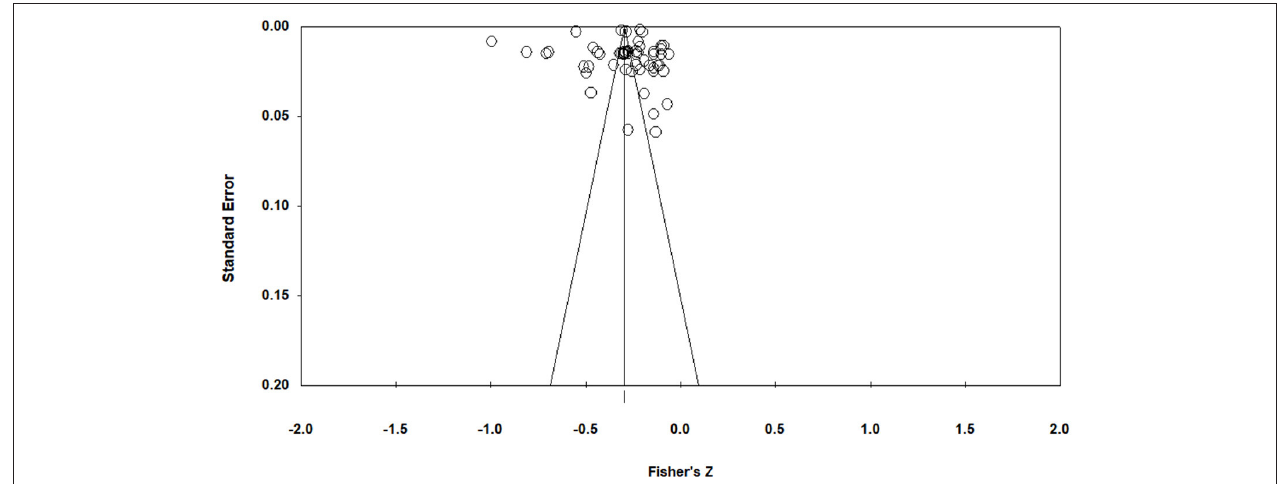
FIGURE 2 | Funnel plot.